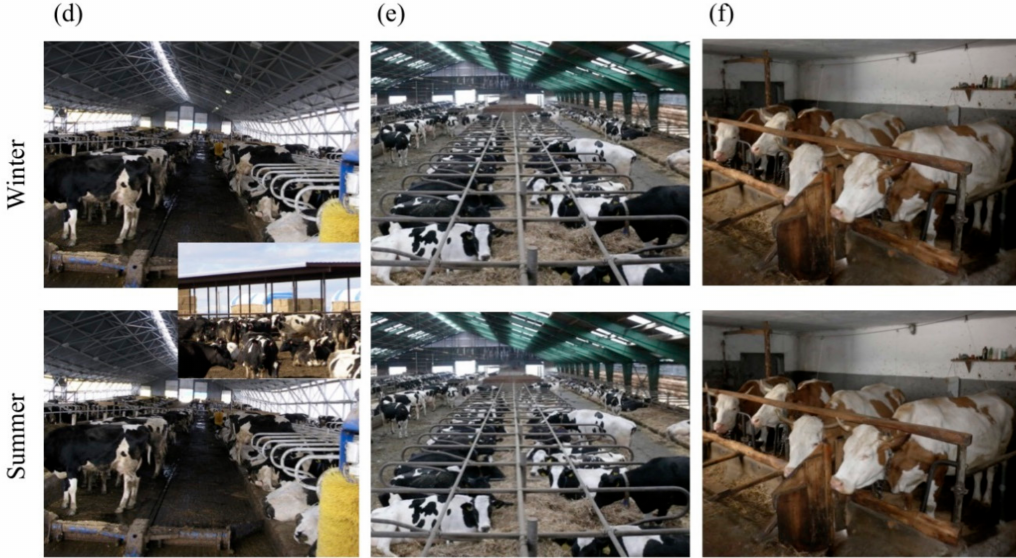
Figure 2. Pictures of six husbandry systems (i.e., cases ( a – f )) representing a variety of housing, breed, and management choices during winter and summertime for dairy